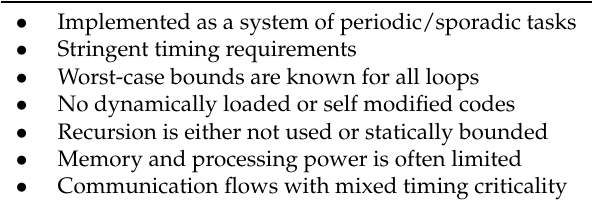
Table 1. Properties of the majority RT-IoT